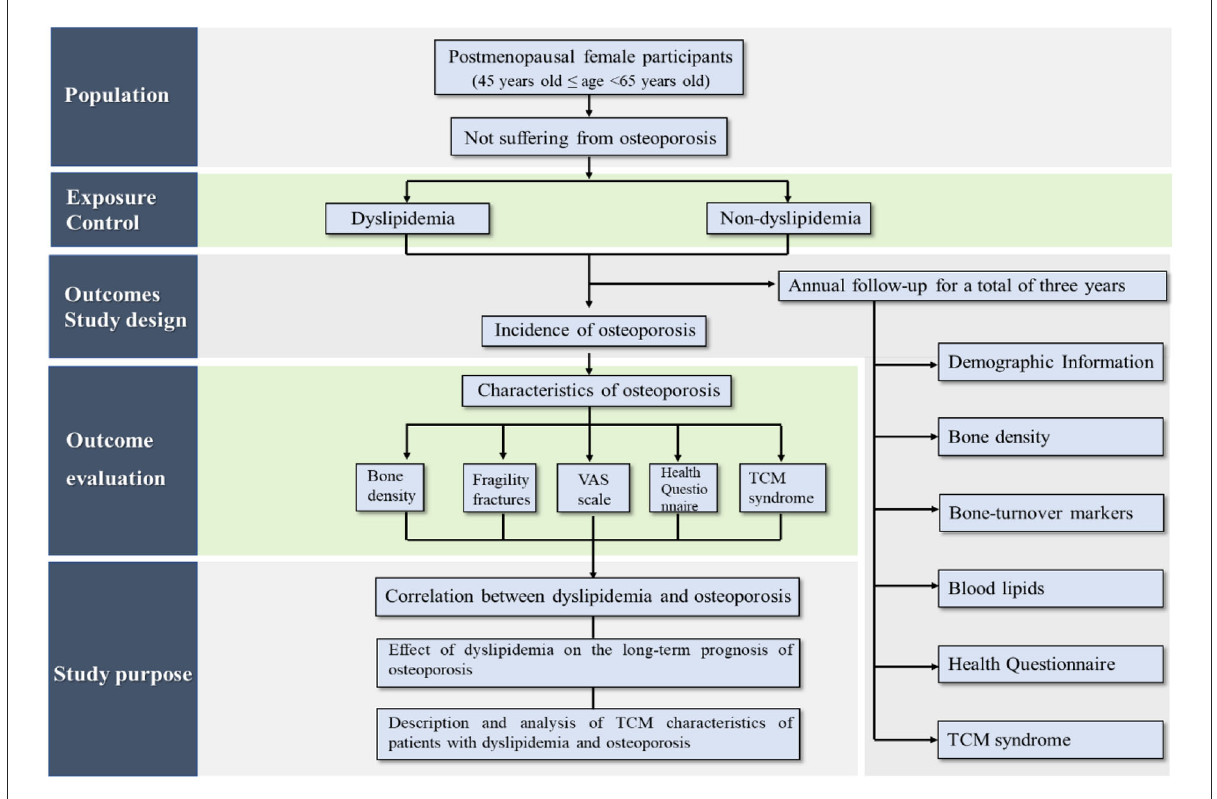
FIGURE1 Flow diagram of the